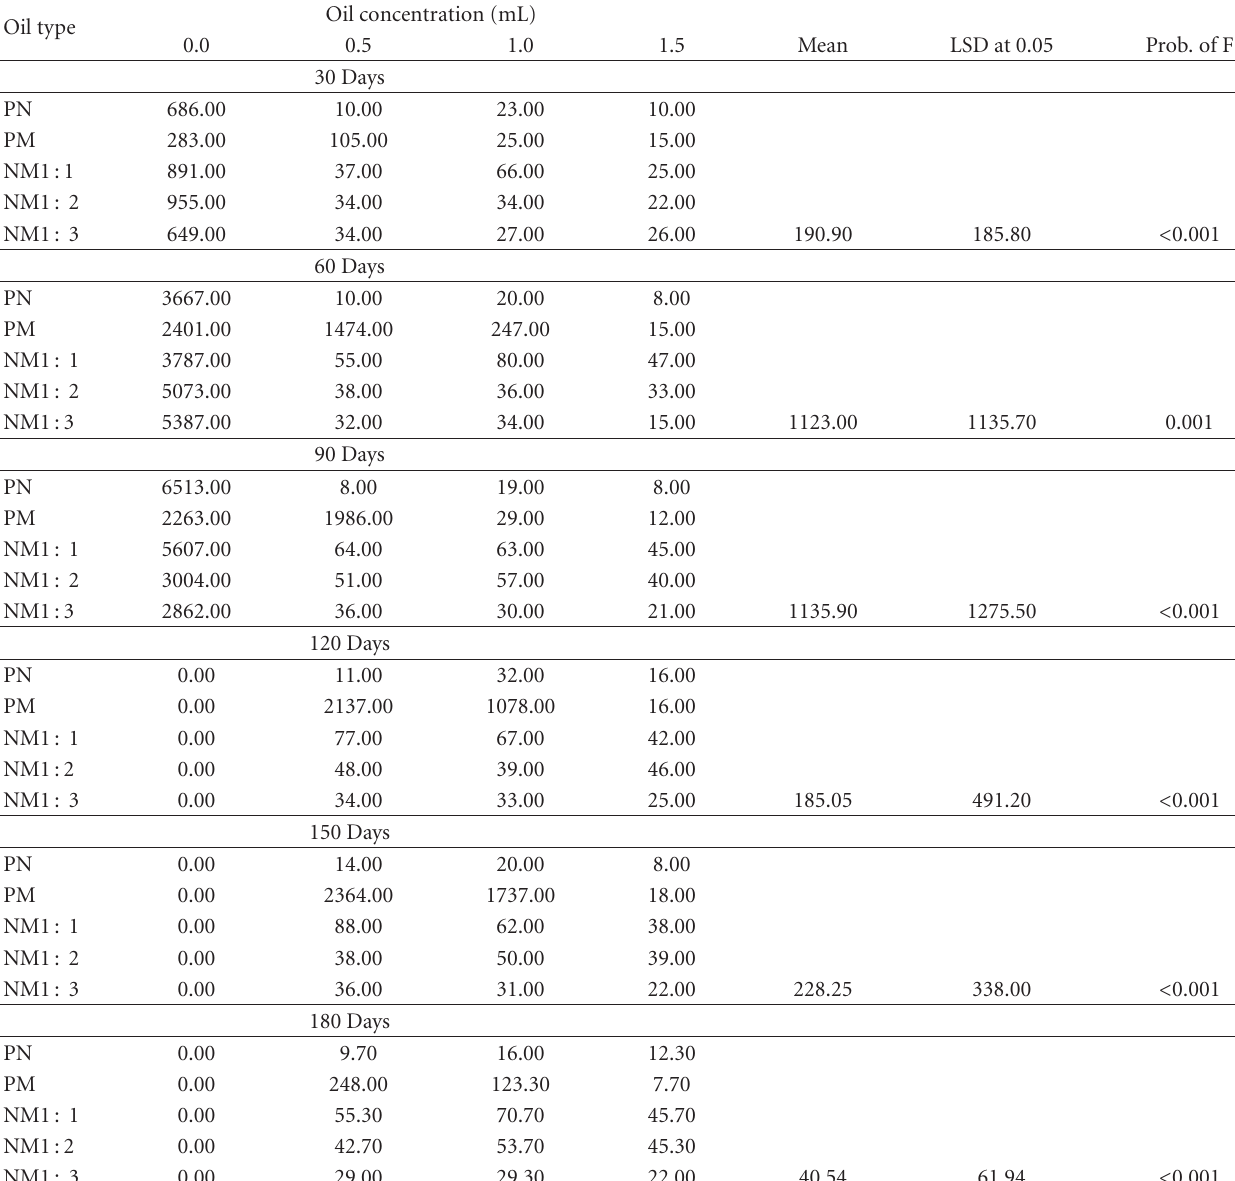
Table 1: Interaction of oil types and various concentrations of the oils on number of eggs laid by C. maculatus on cowpea samples after di ff erent storage